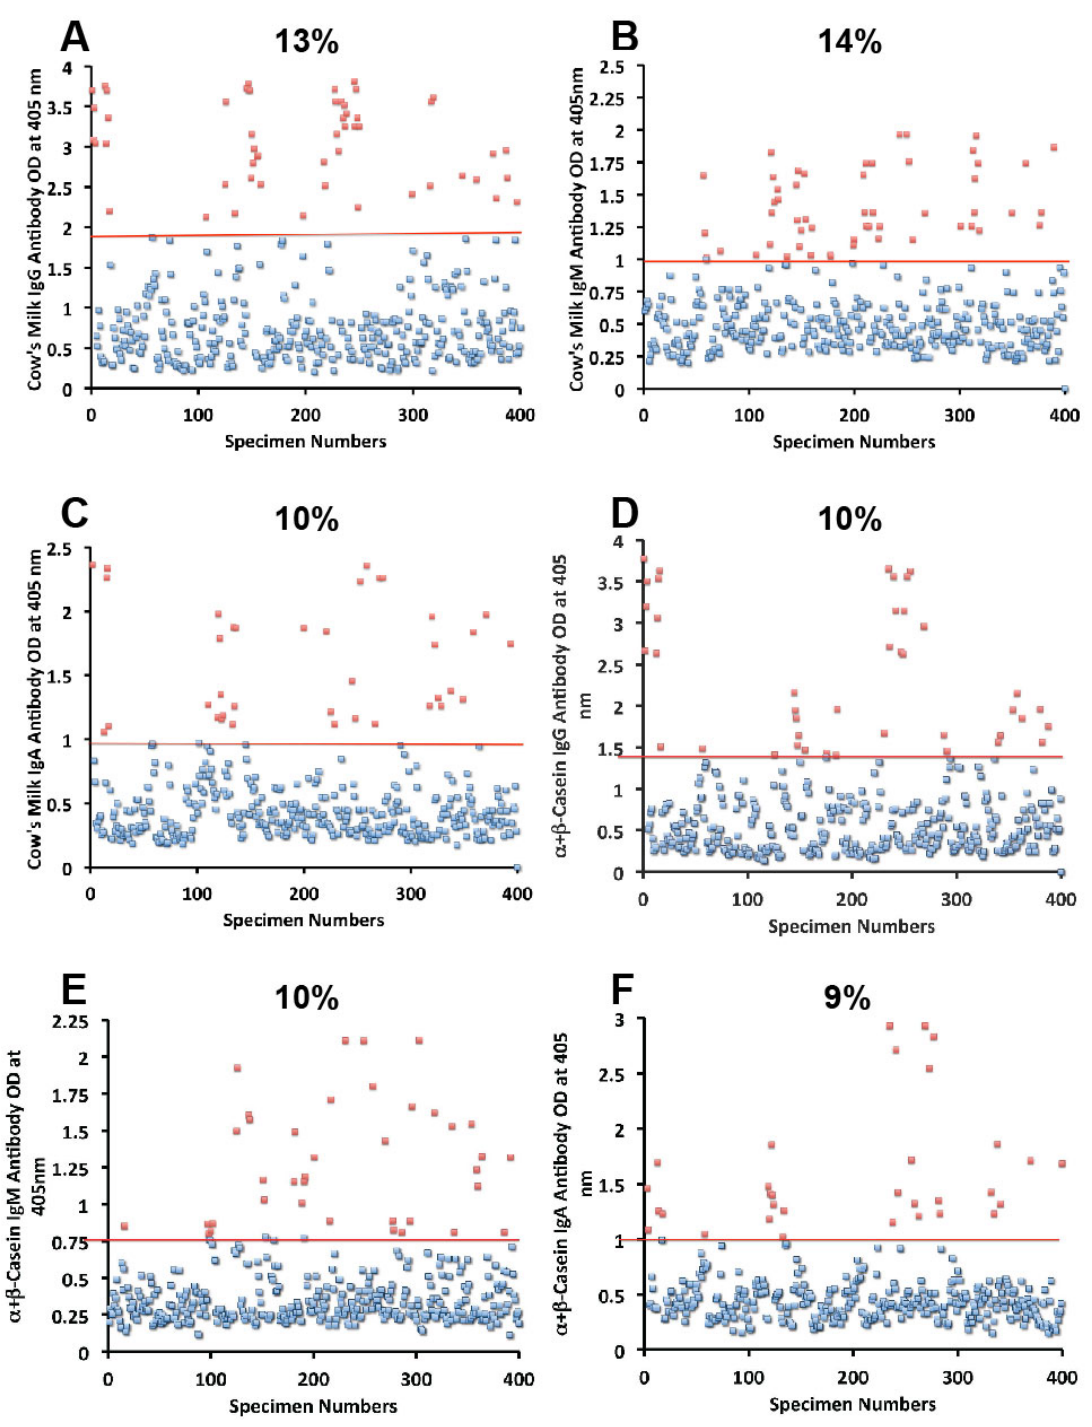
Figure 4. Results for cow’s milk and α + β -casein expressed as OD at 405 nm in the form of scattergrams with percentages of elevation. ( A ) Cow’s milk IgG; ( B ) Cow’s milk IgM; ( C ) Cow’s milk IgA; ( D ) α + β -casein IgG; ( E ) α + β -casein IgM; ( F ) α + β -casein